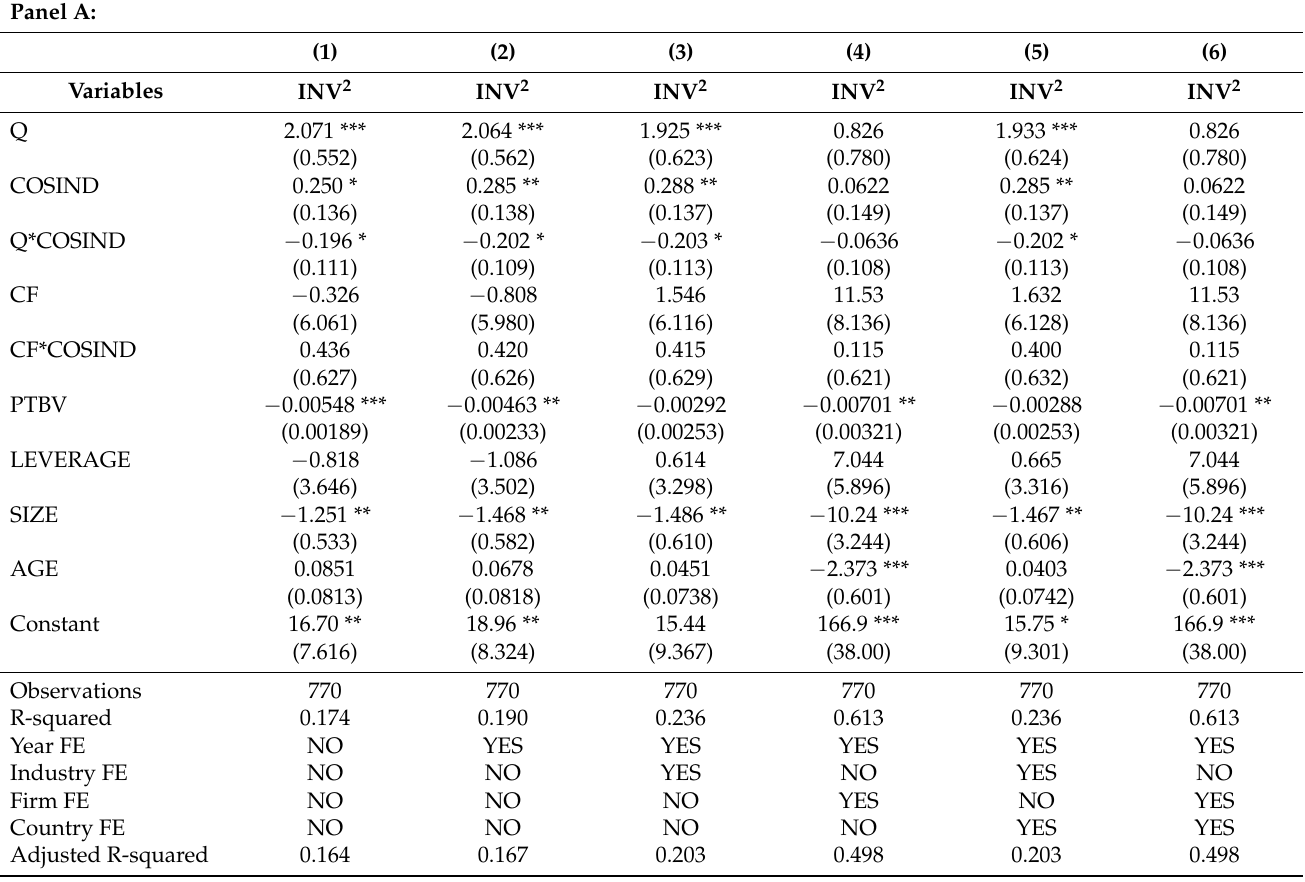
Table 7. The costly CSR initiatives and investment efficiency—robustness